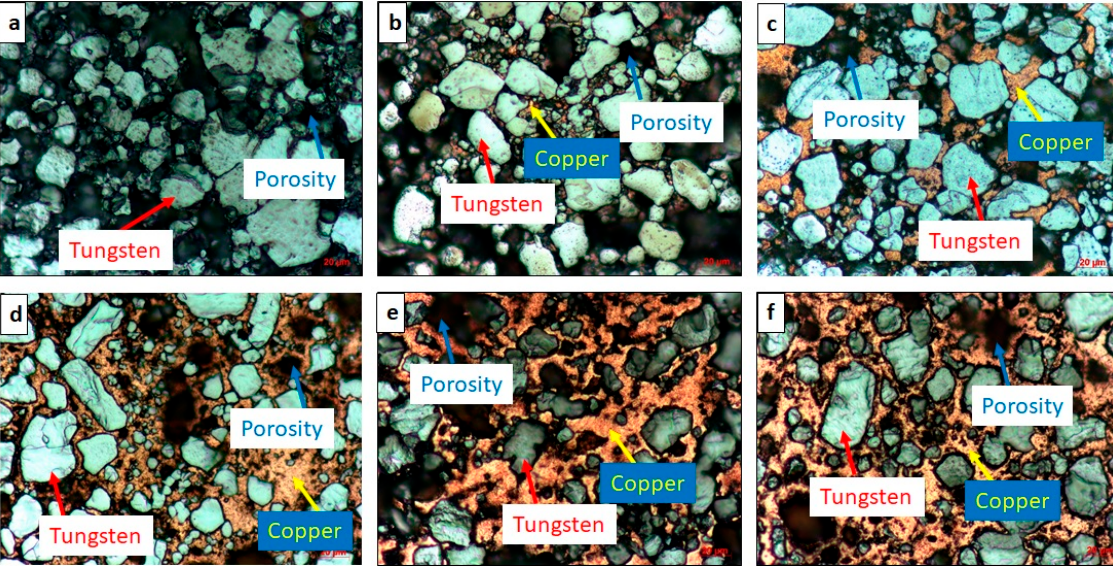
Figure 3. Optical micrographs of ( a ) W100%; ( b ) W95%, Cu5%; ( c ) W90%, Cu10%; ( d ) W85%, Cu15%; ( e ) W80%, Cu20%; ( f ) W75%, Cu25% compacts.